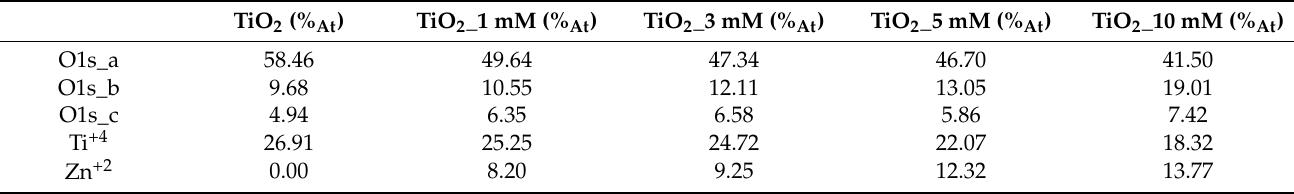
Table 2. Atomic ratio of O1s (O1s_a, O1s_b, and O1s_c), Ti +4 , and Zn +2 for TiO 2 nanosponges and TiO 2 /ZnO hybrid nanosponges electrodeposited for 15 min at 75 ◦ C with Zn(NO 3 ) 2 concentration of 1, 3, 5, and 10